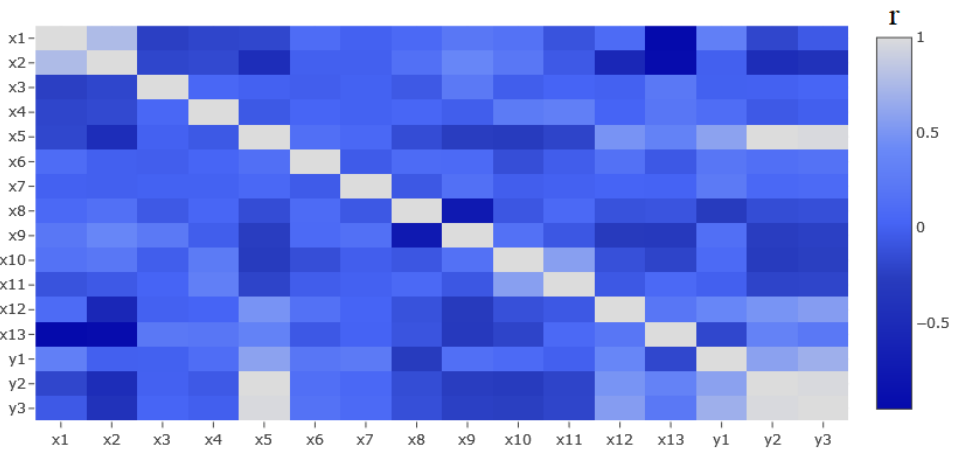
Figure 4. Correlation coefficients r for all 77 data tuples shown as colored correlation plots. The corresponding numerical matrix is given in Table A1 in Appendix